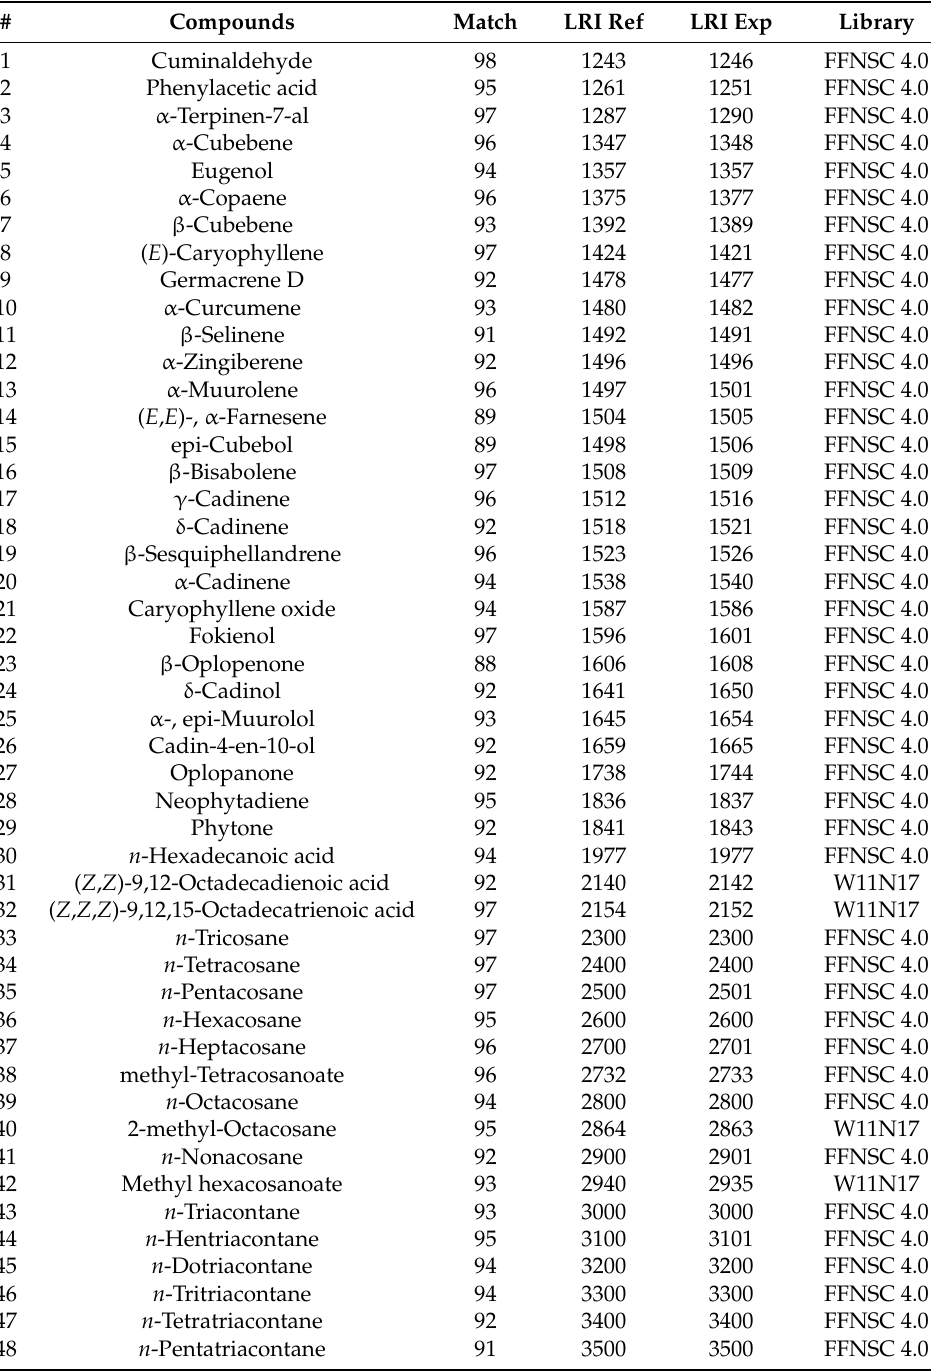
Table 4. List of compounds identified in the n-hexane fraction of I. viscosa by